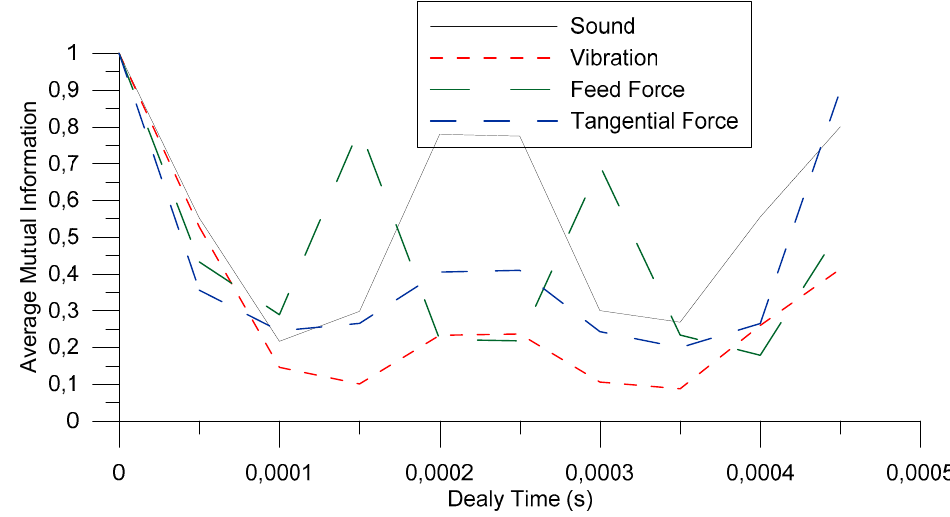
Figure 4. Average mutual information of acquired sensor data for worn inserts versus time lag.